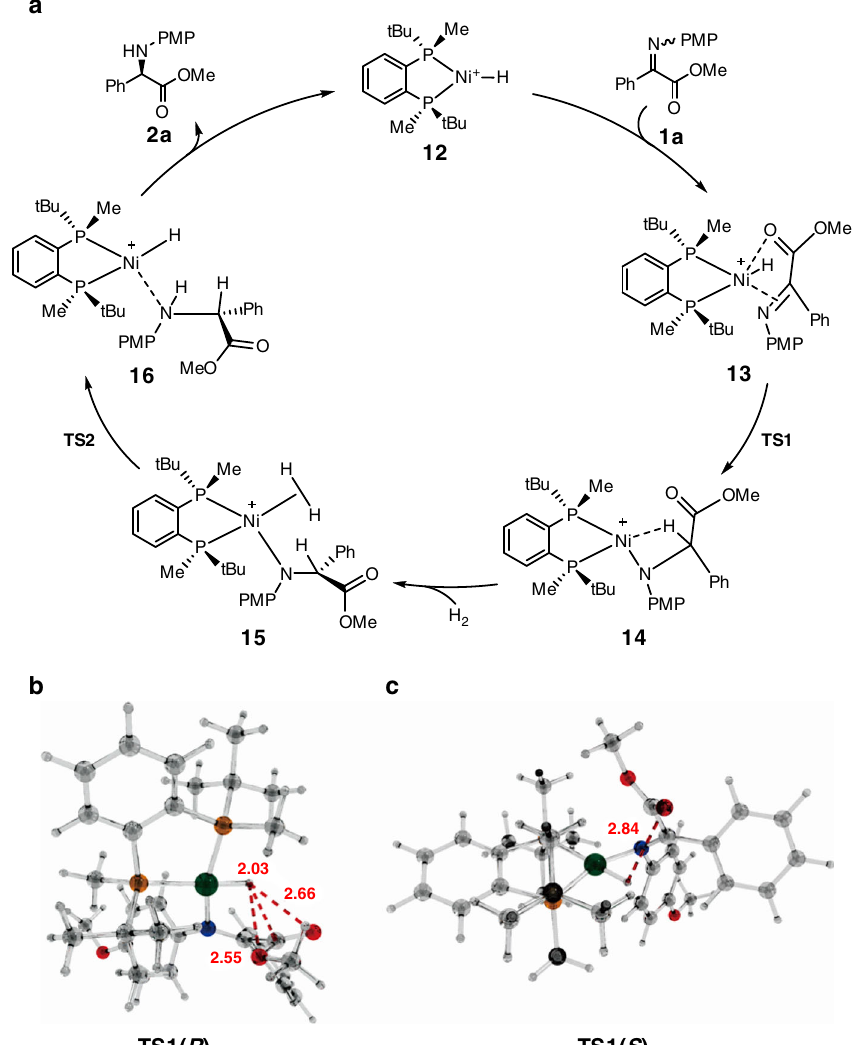
Fig. 4 Computed mechanism of catalytic cycle and important stabilizing interactions (Angstrom). a Computed mechanism of catalytic cycle. b Optimized structures of TS1 ( R ). c Optimized structures of TS1 ( S ).